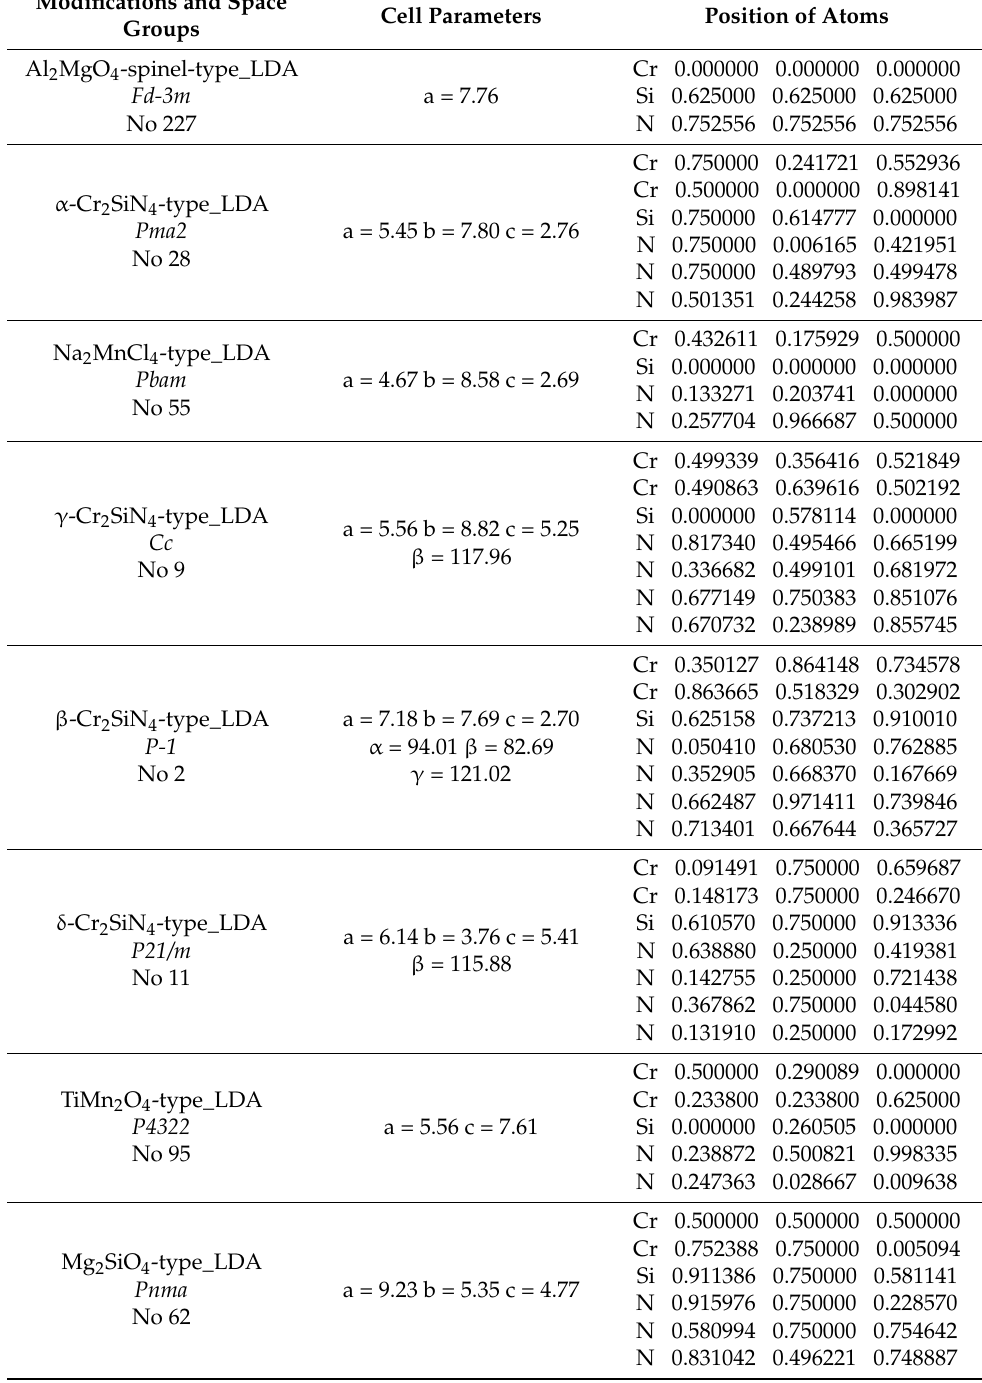
Table A1. The modifications, space groups, unit cell parameters, and atomic positions for the most favorable Cr 2 SiN 4 modifications after structural optimization on the DFT-LDA